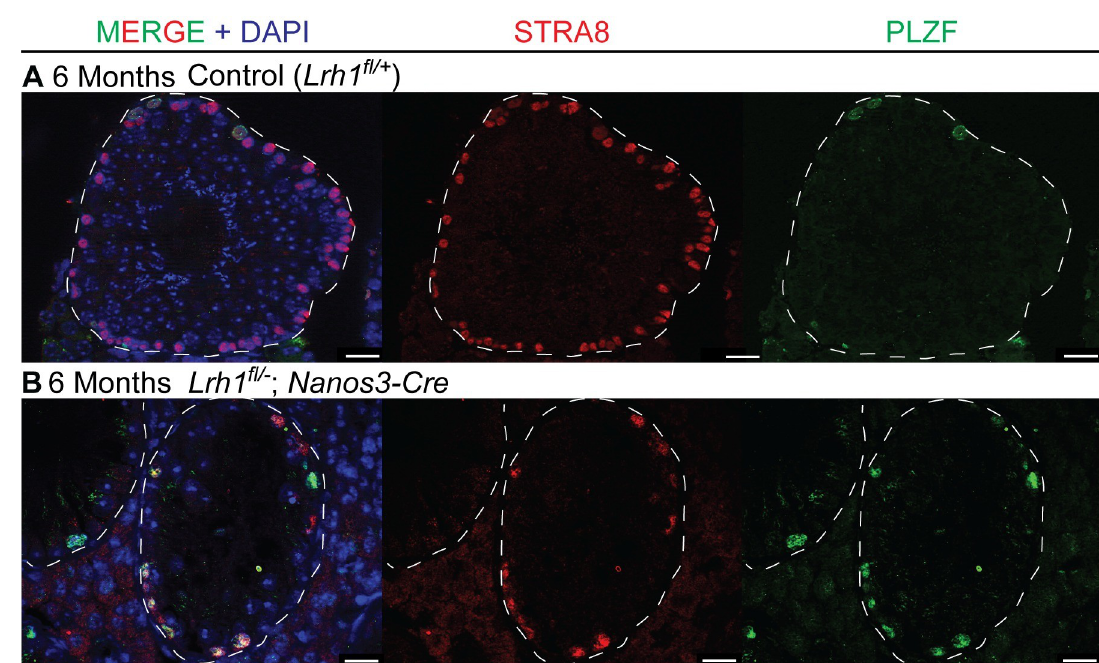
Fig 12. Loss of Lrh1 causes failure of spermatogonial differentiation. IF of sections from control (A) or germ cell-specific Nanos3-Cre Lrh1 mutant (B) testes stained for STRA8 (red), PLZF (green) and DAPI (blue) at 6 months, showing persistence of spermatogonia with depletion of differentiated germ cells. Scale bars: 100 um.